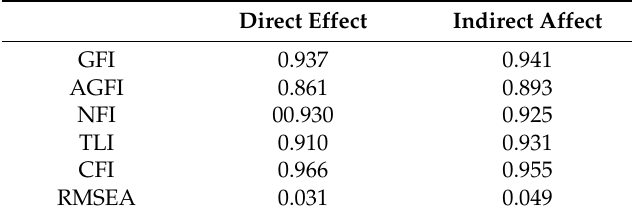
Table 2. Model Fitness.